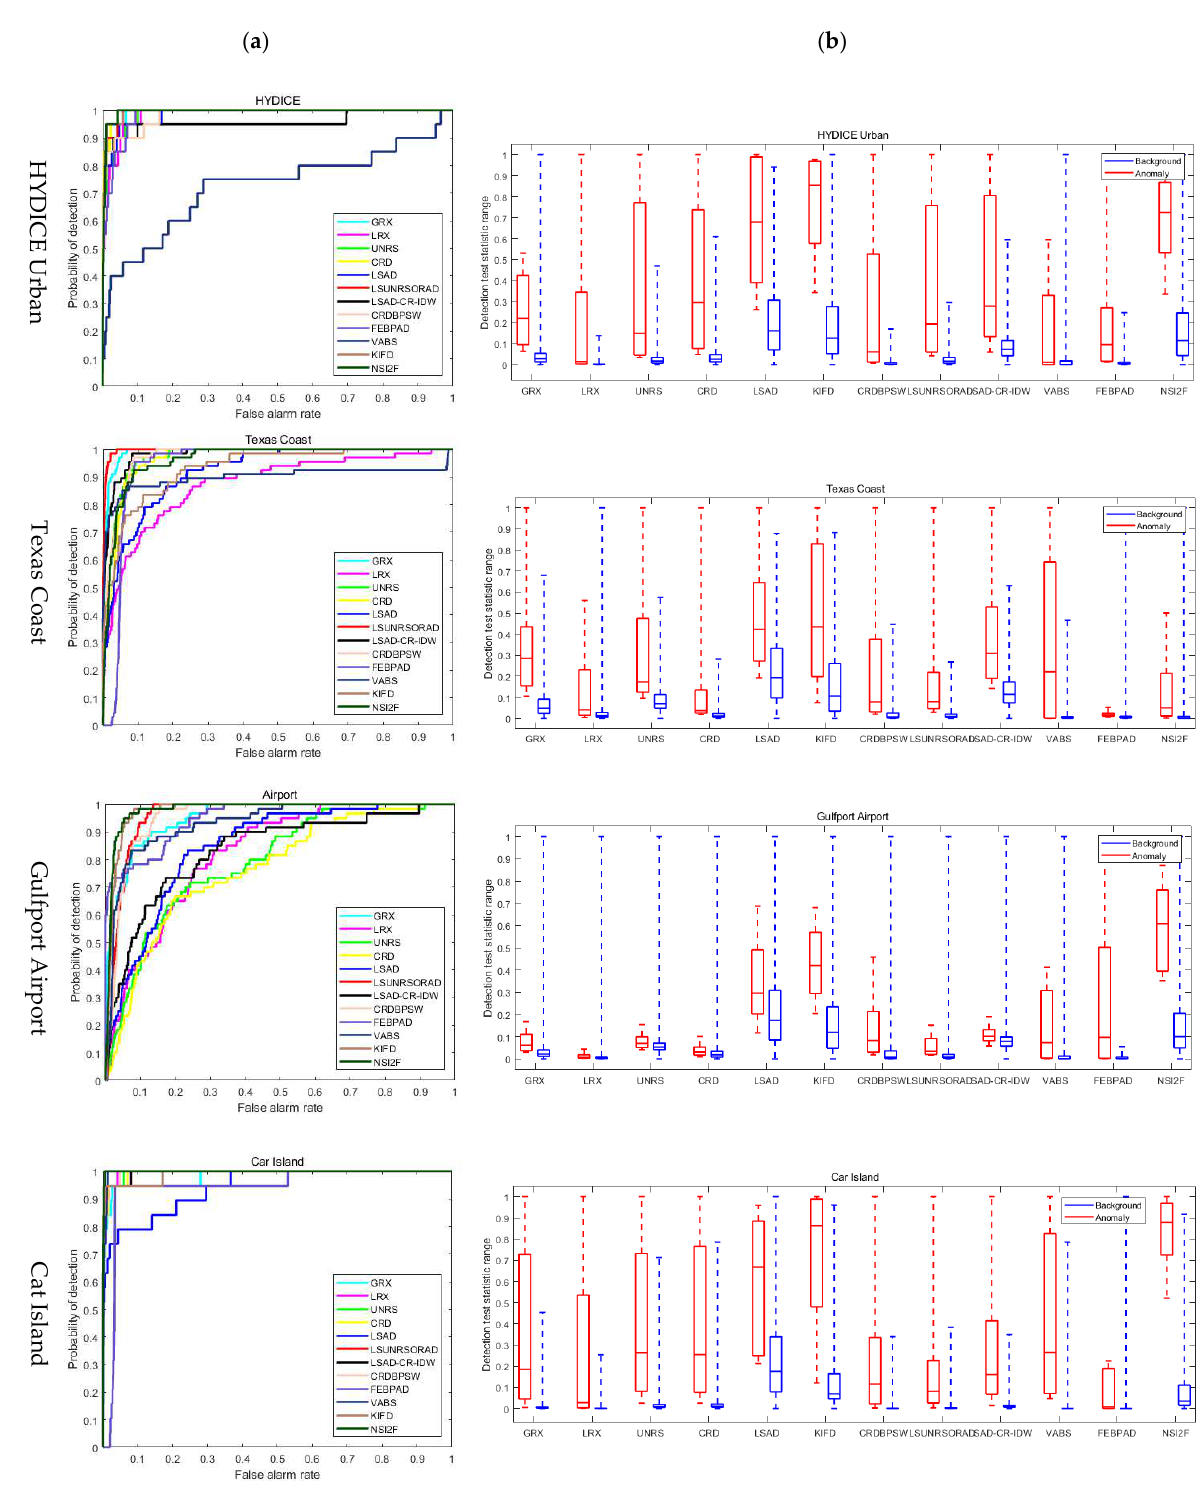
Figure 10. ROC curves and target background separation boxplot on four datasets. ( a ) ROC curves; ( b ) Target background separation boxplot.